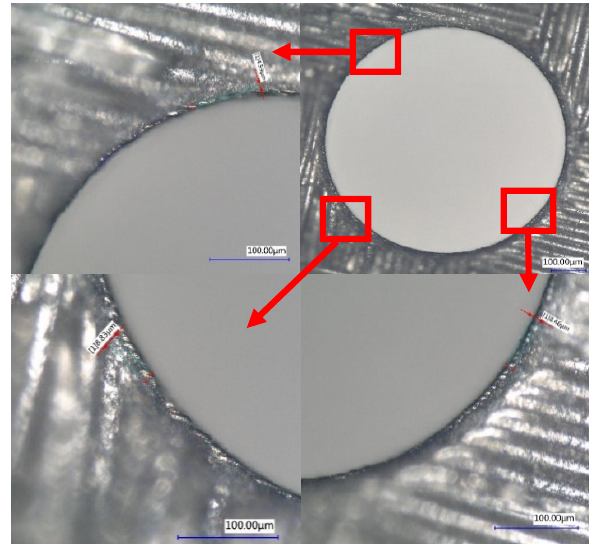
Figure 13. The HAZ size at the hole’s entrance.